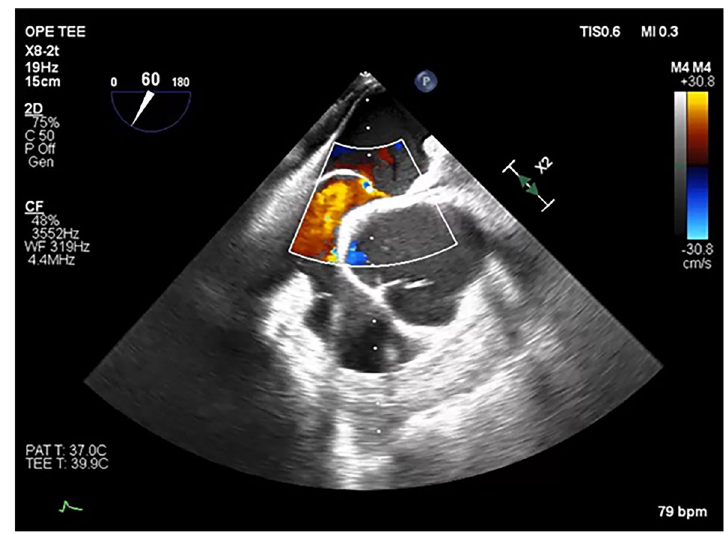
Fig. 4 Doppler image of aortic valve short axis view on transesophageal echocardiography. A marked right-to-left shunt through the patent foramen